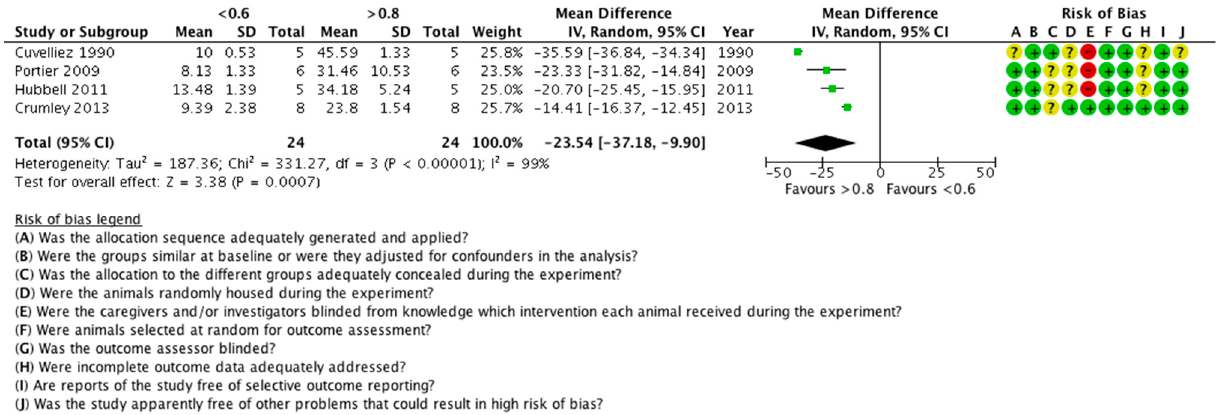
Figure 4. Forest plot of the effect of the F I O 2 on PaO 2 . Units are in kPa. CI: confidence interval; IV: inverse variance; SD: standard deviation. ?: unclear risk; -: high risk; +: low risk.